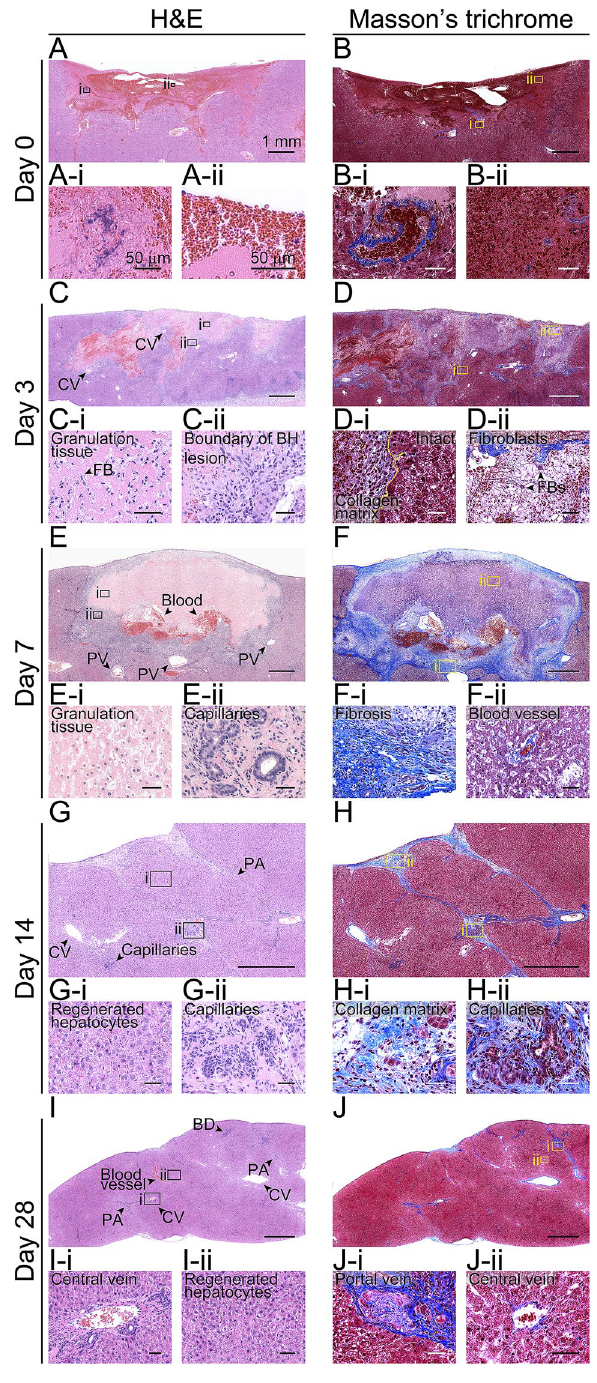
Figure 2. Cross-sectional images of the BH-treated liver tissues. ( A – J ) Histological images of hematoxylin and eosin (H&E) or Masson’s trichrome stained liver tissues collected on days 0, 3, 7, 14 and 28 after the BH treatment. ( A – J ) BH treated region. (Scale bar, 1 mm; magnification 50 ×). Images (i) and (ii) show the highlighted areas in ( A to J ) at higher magnifications. (Scale bar, 50 µm; magnification 400 ×) CV: central vein, FB: fibroblast, PA: Portal area, and PV: Portal